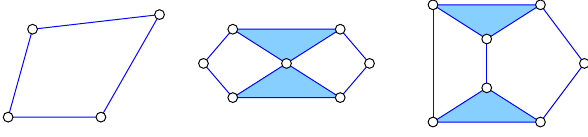
Figure 2. Four-bar, Watt’s and Stephenson’s one-DOF